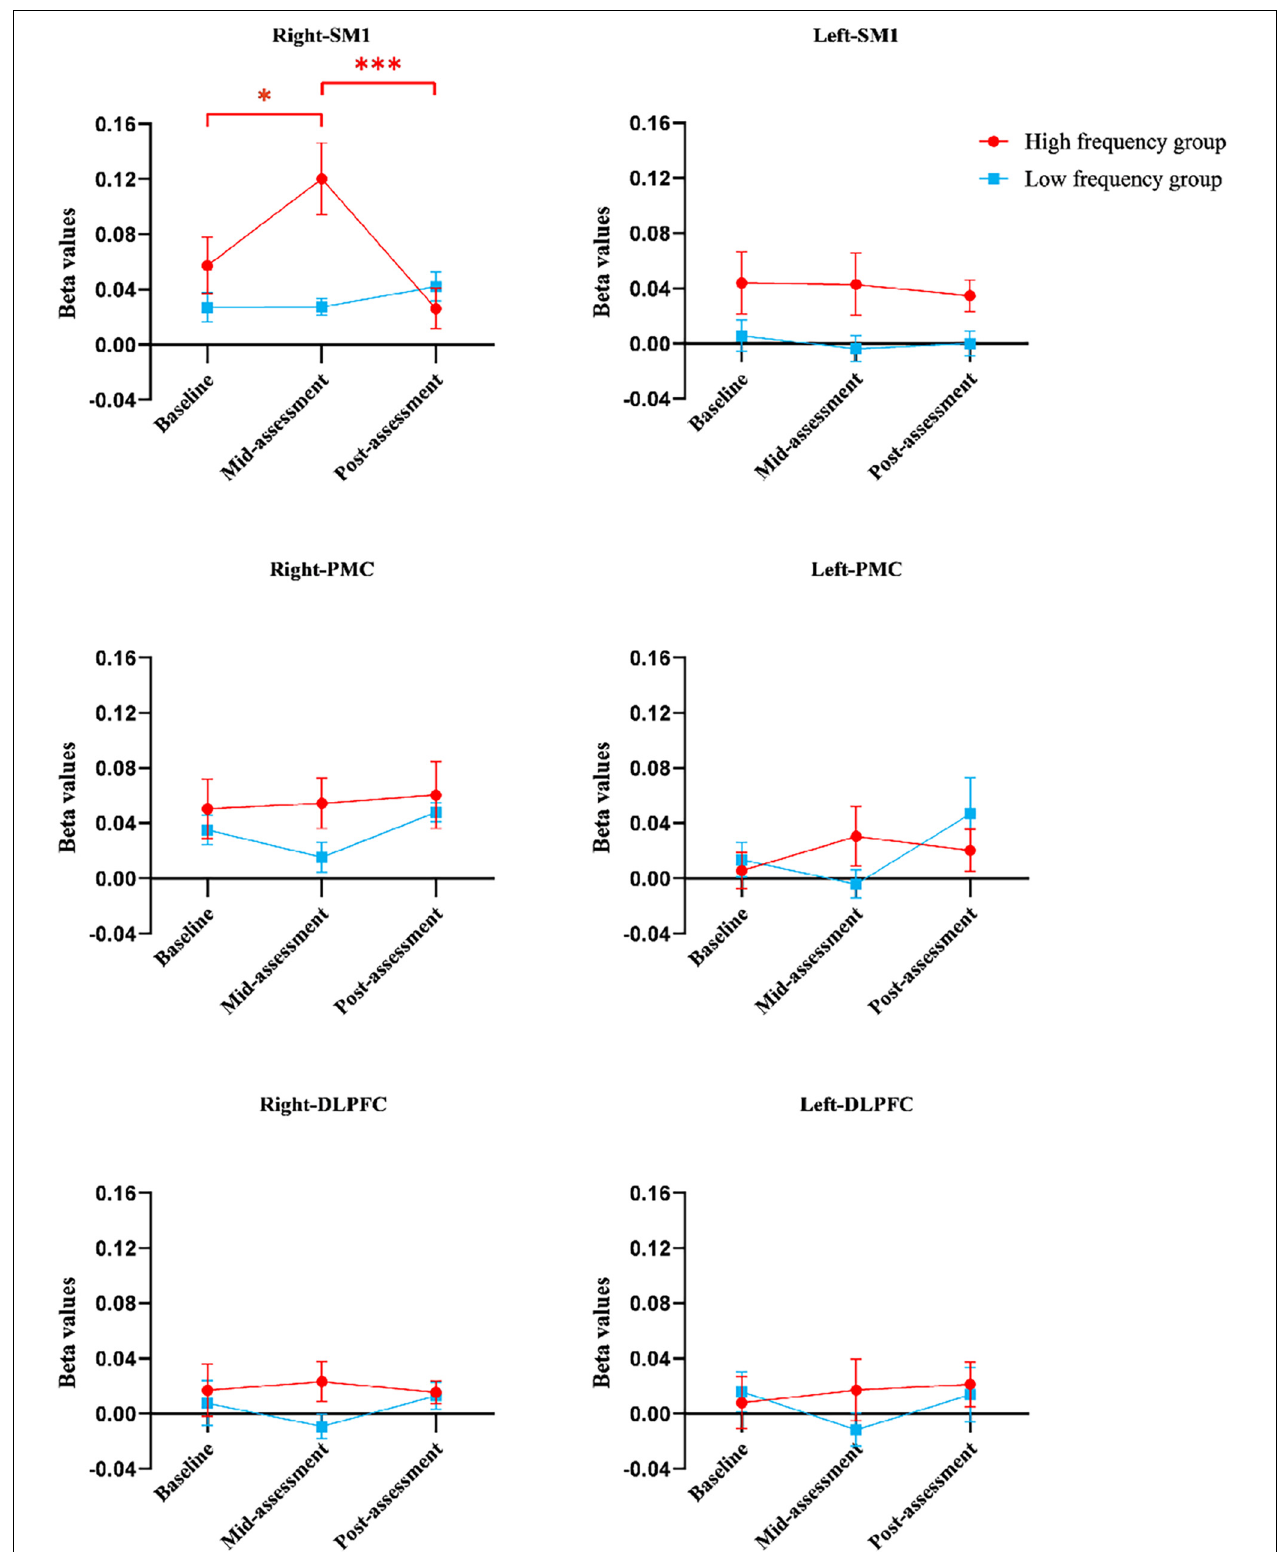
FIGURE 5 | The beta values of regions of interests in different groups at three assessment time-points. Error bars represent standard errors. *Indicates statistical significance P < 0.05 and ***indicates statistical significance P < 0.001. DLPFC, dorsolateral prefrontal cortex; PMC, promoter cortex; SM1, primary sensory-motor